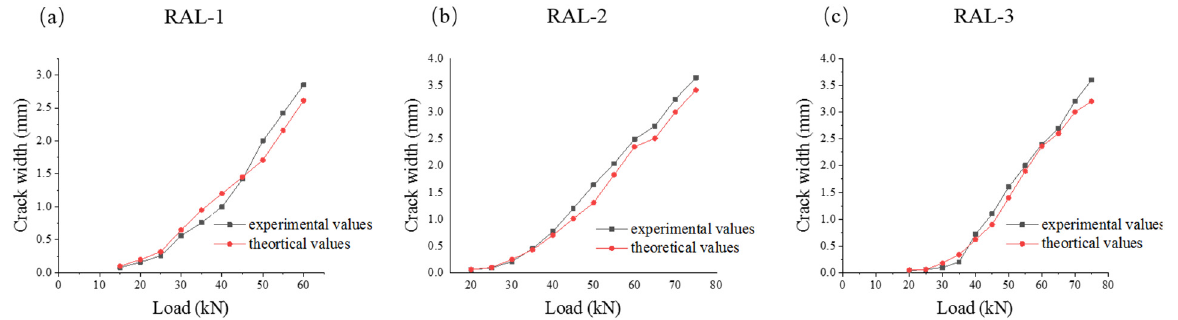
Figure 8. Comparison between experimental and theoretical values of crack width of test beam. ( a ) RAL-1, ( b ) RAL-2, ( c ) RAL-3 .